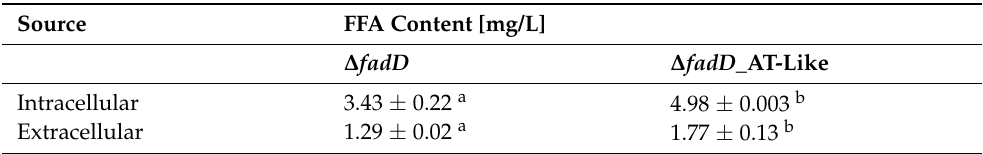
Table 1. Free fatty acid (FFA) content in the ∆ fadD mutant expressing the AT-like domain. Values are reported as means ± standard deviations for three biological replicates. Means with different letters in the same row are statistically different according to an unpaired t -test ( p < 0.05). Source FFA Content [mg/L] ∆ fadD ∆ fadD _AT-Like